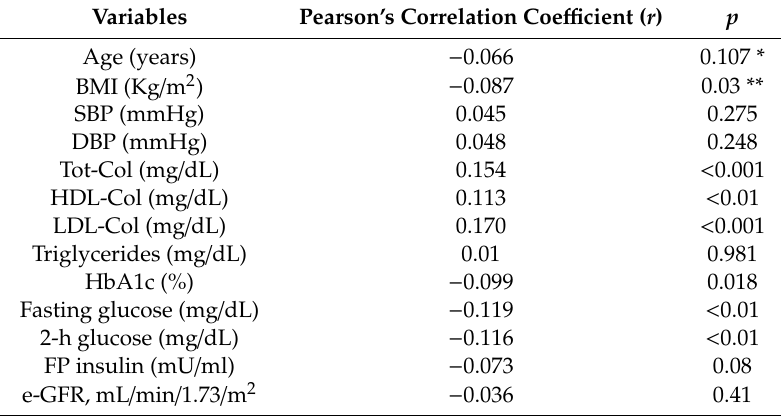
Table 2. Univariate correlations between Mg 2 + levels and anthropometric and metabolic variables.